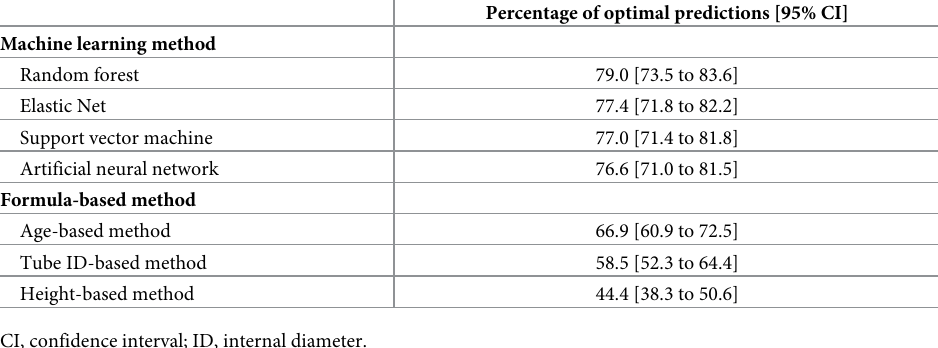
Table 2. The percentage of optimal predictions for tracheal tube tip location for each prediction model (test data).